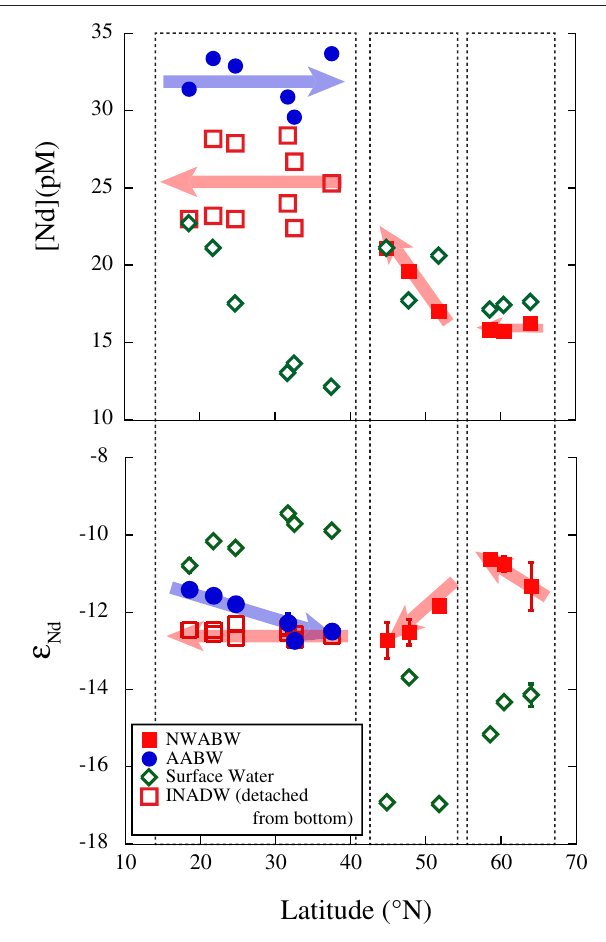
FIGURE 3 | Bottom water [Nd] and ε Nd from Lambelet et al. (2016). Arrows show interpretation of flow paths of bottom water.